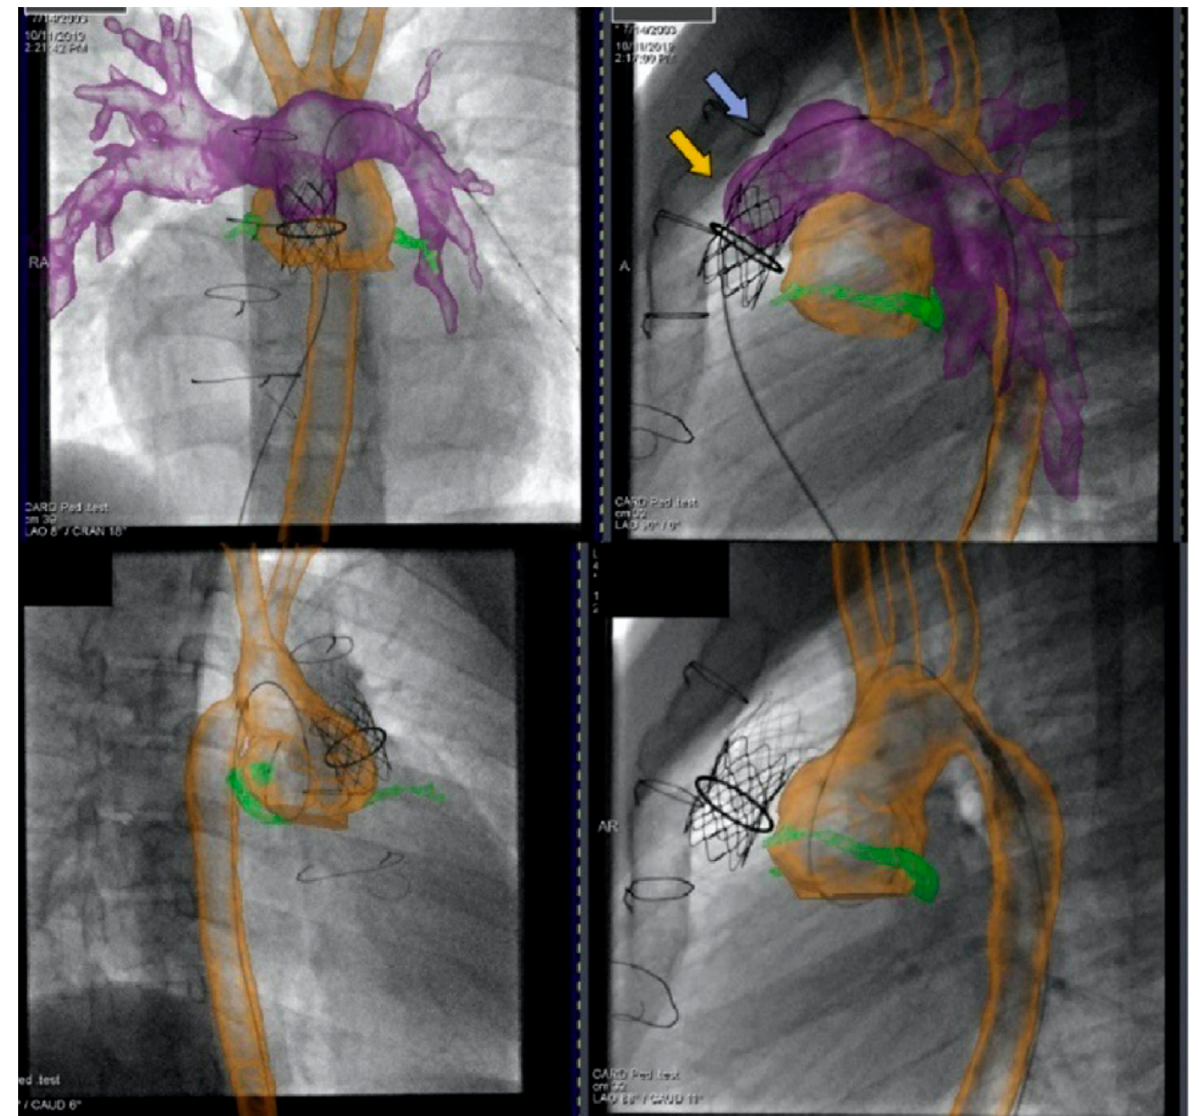
Figure 19. Biplane overlay (Siemens Healthineers, Munich, Germany) to assist with Melody valve placement (top row) followed by coarctation of the aorta (CoA) stenting in the same patient (bottom row). The pulmonary arteries are outlined in purple, and the aorta is outlined in orange. The two arrows point to the bare metal stent (yellow) within the valved conduit and newly placed Melody valve (violet). Ref [13].